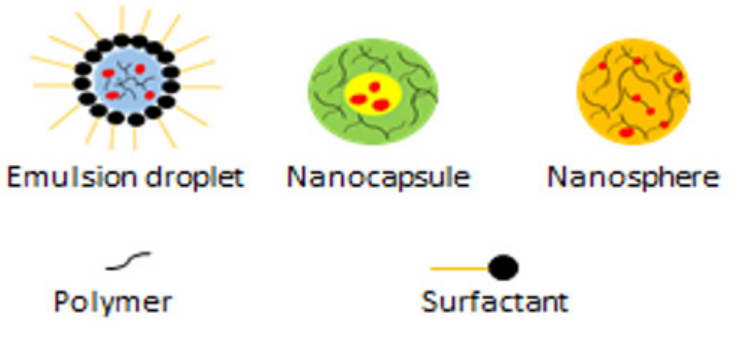
Figure 5. Polymeric Nanoparticles.